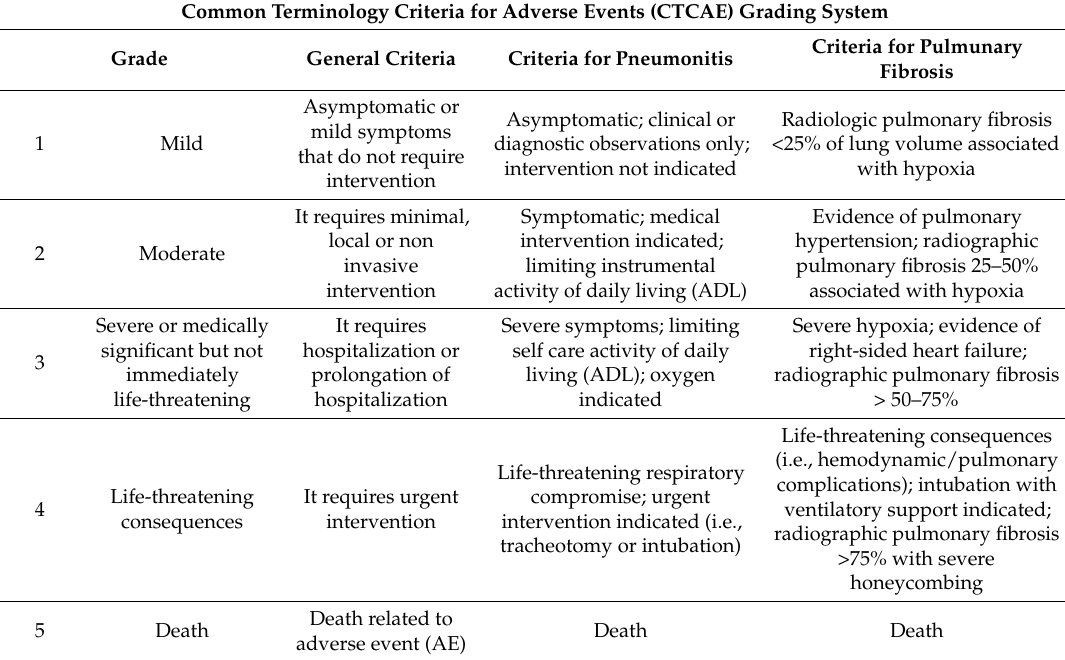
Table 2. CTCAE grading system